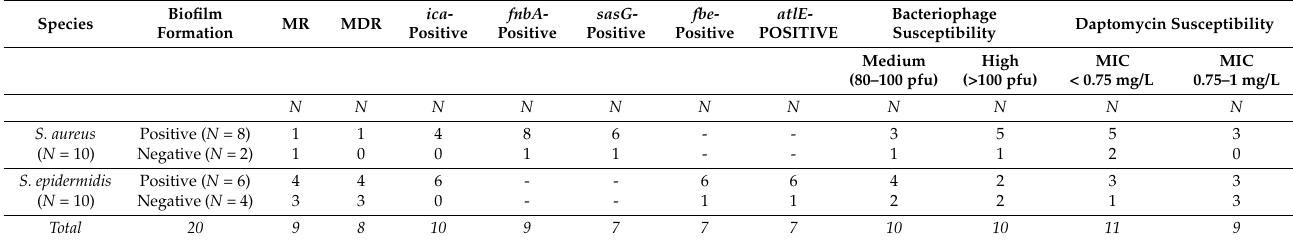
Table 1. Phenotypic and genotypic characteristics of S. aureus and S. epidermidis studied strains. MR: methicillin-resistant; MDR: multi-drug resistant; MIC: Minimum inhibitory concentration; N: number of strains. Species Biofilm